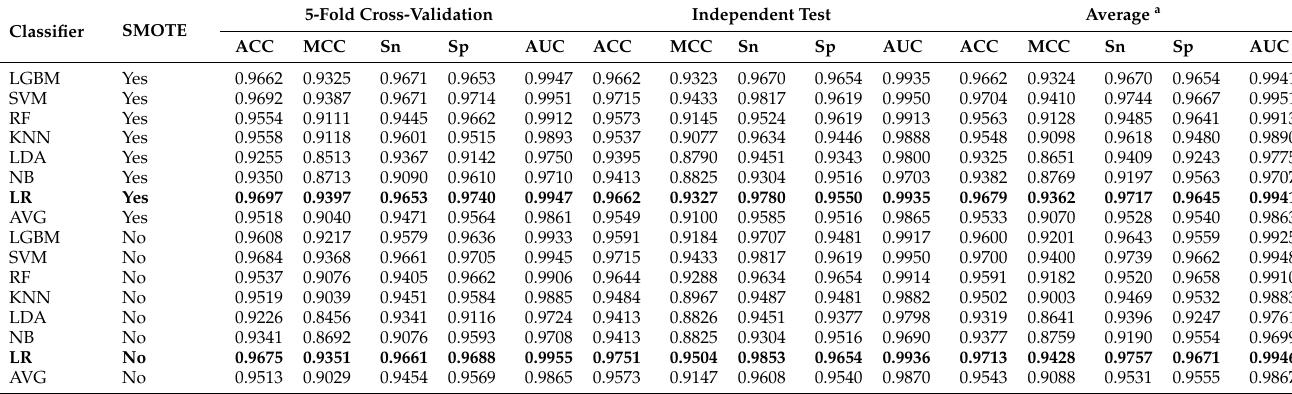
Table 1. Performance of models using BERT-bfd feature with seven different classifiers.